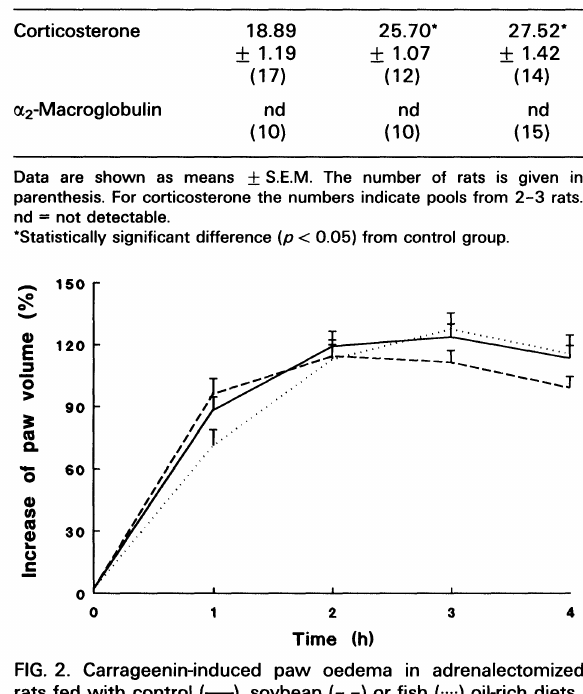
FIG. 2. Carrageenin-induced paw oedema in adrenalectomized rats fed with control (), soybean (- -) or fish oil-rich